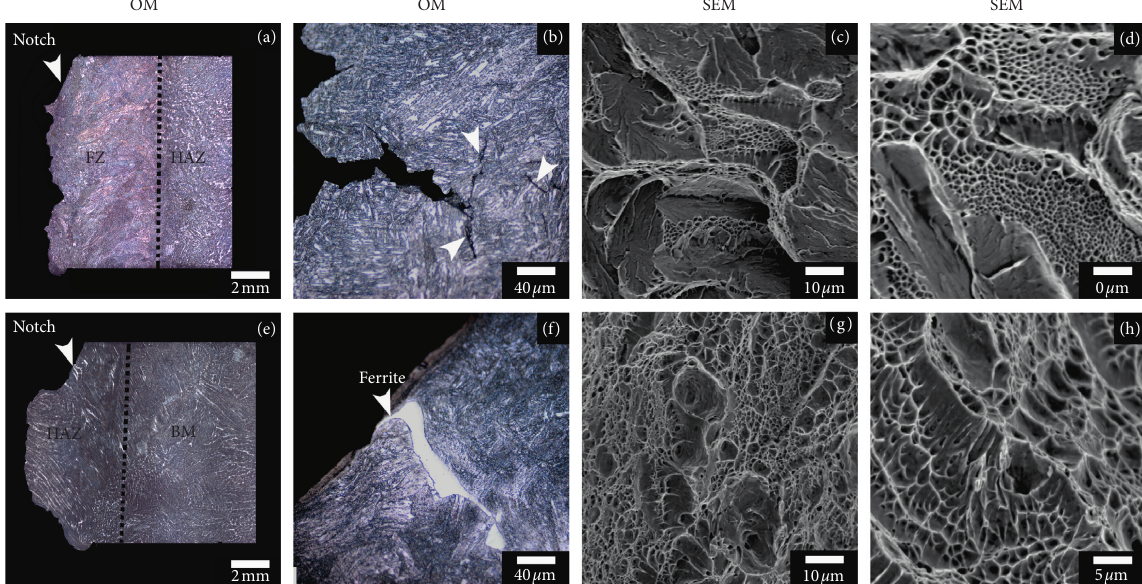
Figure 11: Representative images of the Charpy impact fracture tips and surfaces for PWHTed CA6NM in (a–d) FZ (CVNF2 samples) and (e–h) HAZ (CVNH2